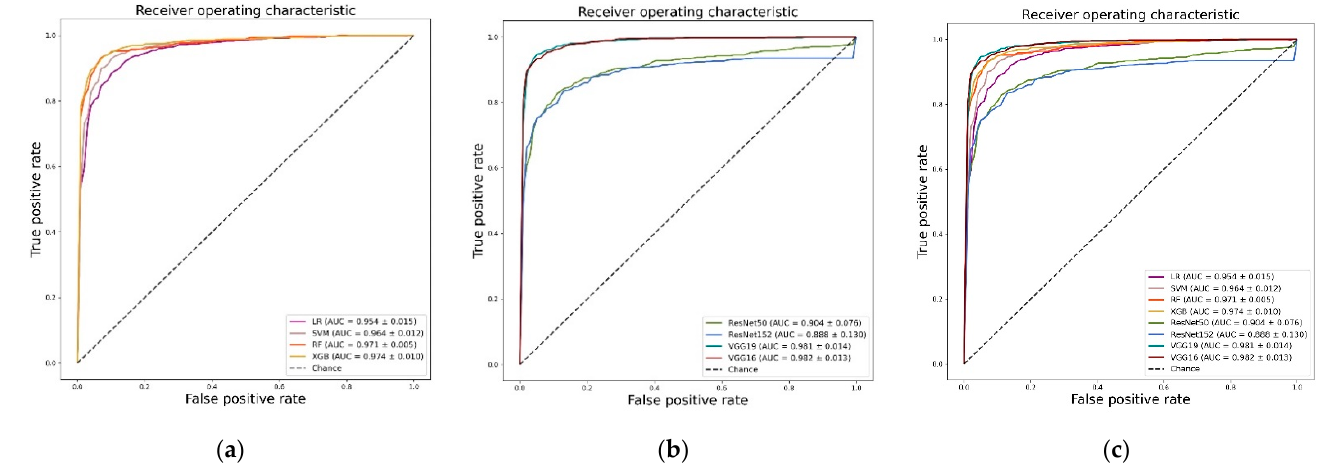
Figure 3. Receiver operation characteristic (ROC) curves: ( a ) ROC curves of machine learning algorithms; ( b ) ROC curves of deep learning algorithms; ( c ) ROC curves of all algorithms.